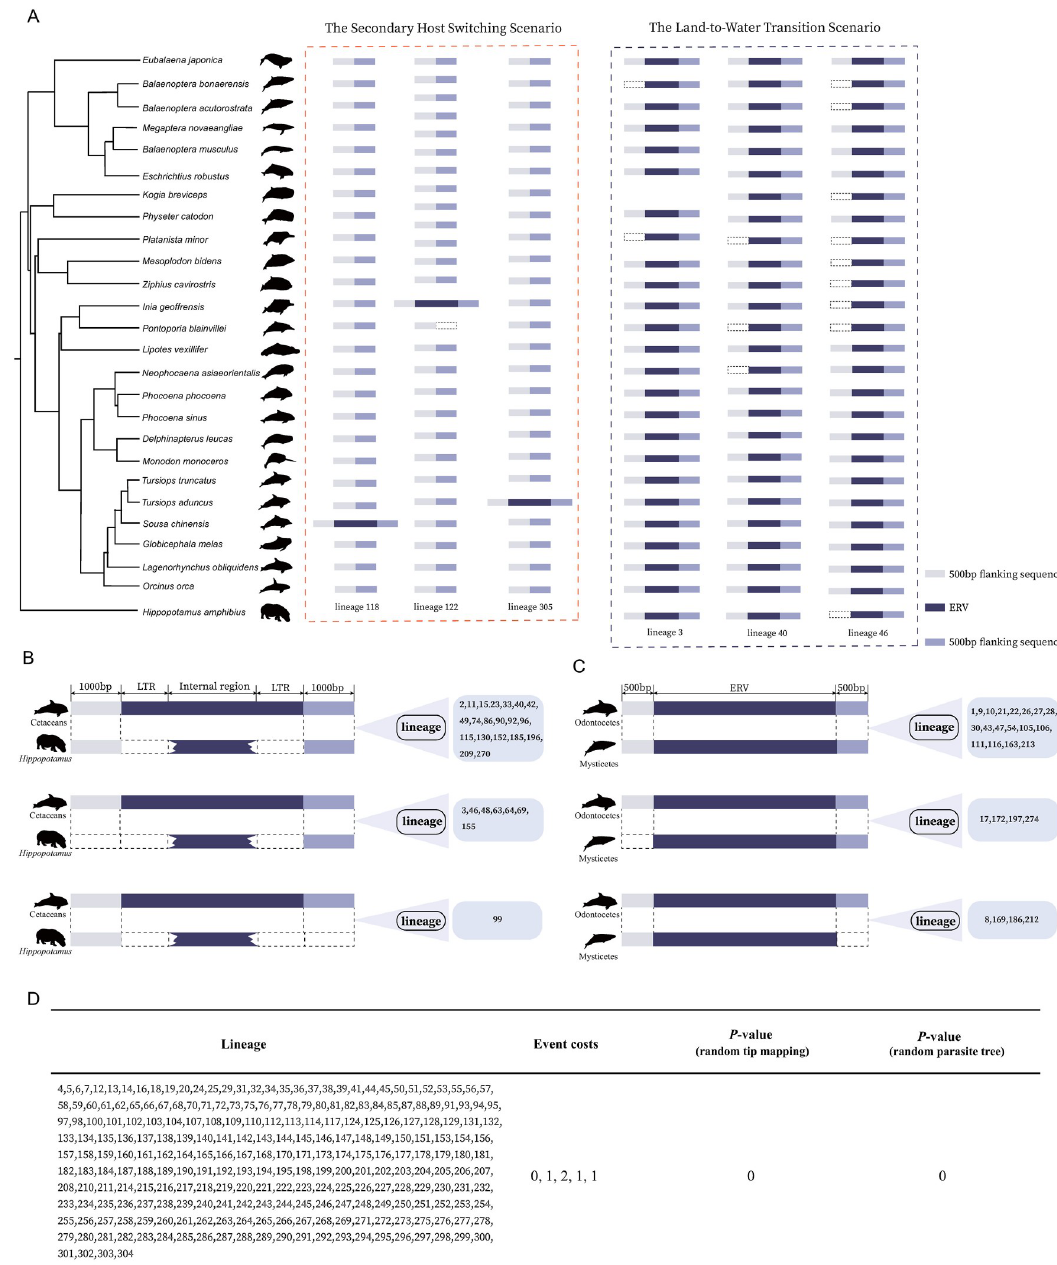
Fig 4. ERV orthologous insertions in cetaceans. ( A ) Examples of orthologous insertions for the SHS and the LTW ERV lineages. The phylogenetic relationship of cetaceans is shown on the left. The dotted boxes in red and blue show orthologous ERV insertions for the SHS and the LTW scenarios, respectively. The white and mauve rectangles represent 500 bp sequences flanking complete ERVs. The deep purple rectangles represent complete ERVs. Illustrations of cetacean species courtesy by Chris Huh. ( B ) ERV orthologous insertions between cetaceans and H . amphibious . Rectangles from left to right represent 1,000 bp flanking sequence, 5’- LTR, internal genes of an ERV, 3’-LTR, and 1,000 bp flanking sequence, respectively. Dashed boxes indicate missing of the corresponding regions. ( C ) ERV orthologous insertions between mysticetes and odontocetes. Rectangles from left to right represent 500 bp flanking sequence, ERV, and 500 bp flanking sequence, respectively. Dashed boxes indicate missing of the corresponding regions. ( D ) ERV and cetacean phylogeny congruence test. The event cost scheme (0, 1, 2, 1, 1) is for cospeciation, duplication, duplication with host switch, loss, and failure to diverge, respectively.